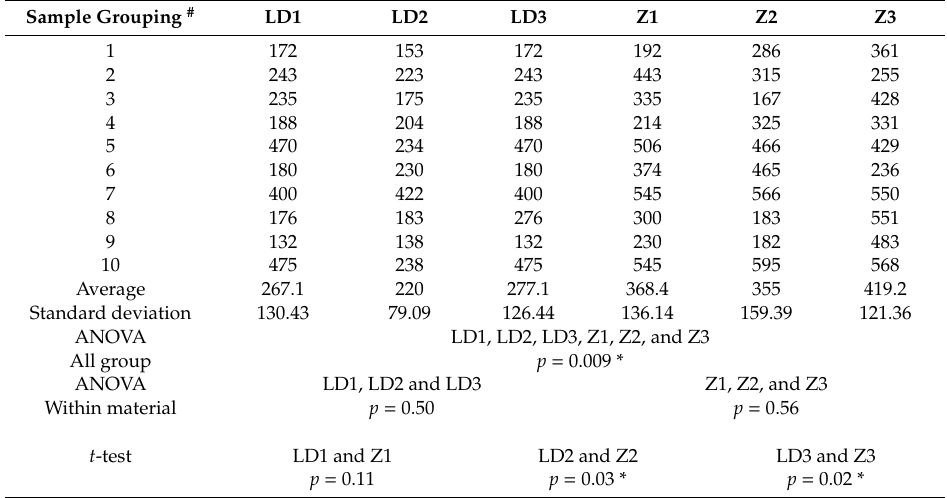
Table 1. Er:YAG laser-assisted crown retrieval time (sec).